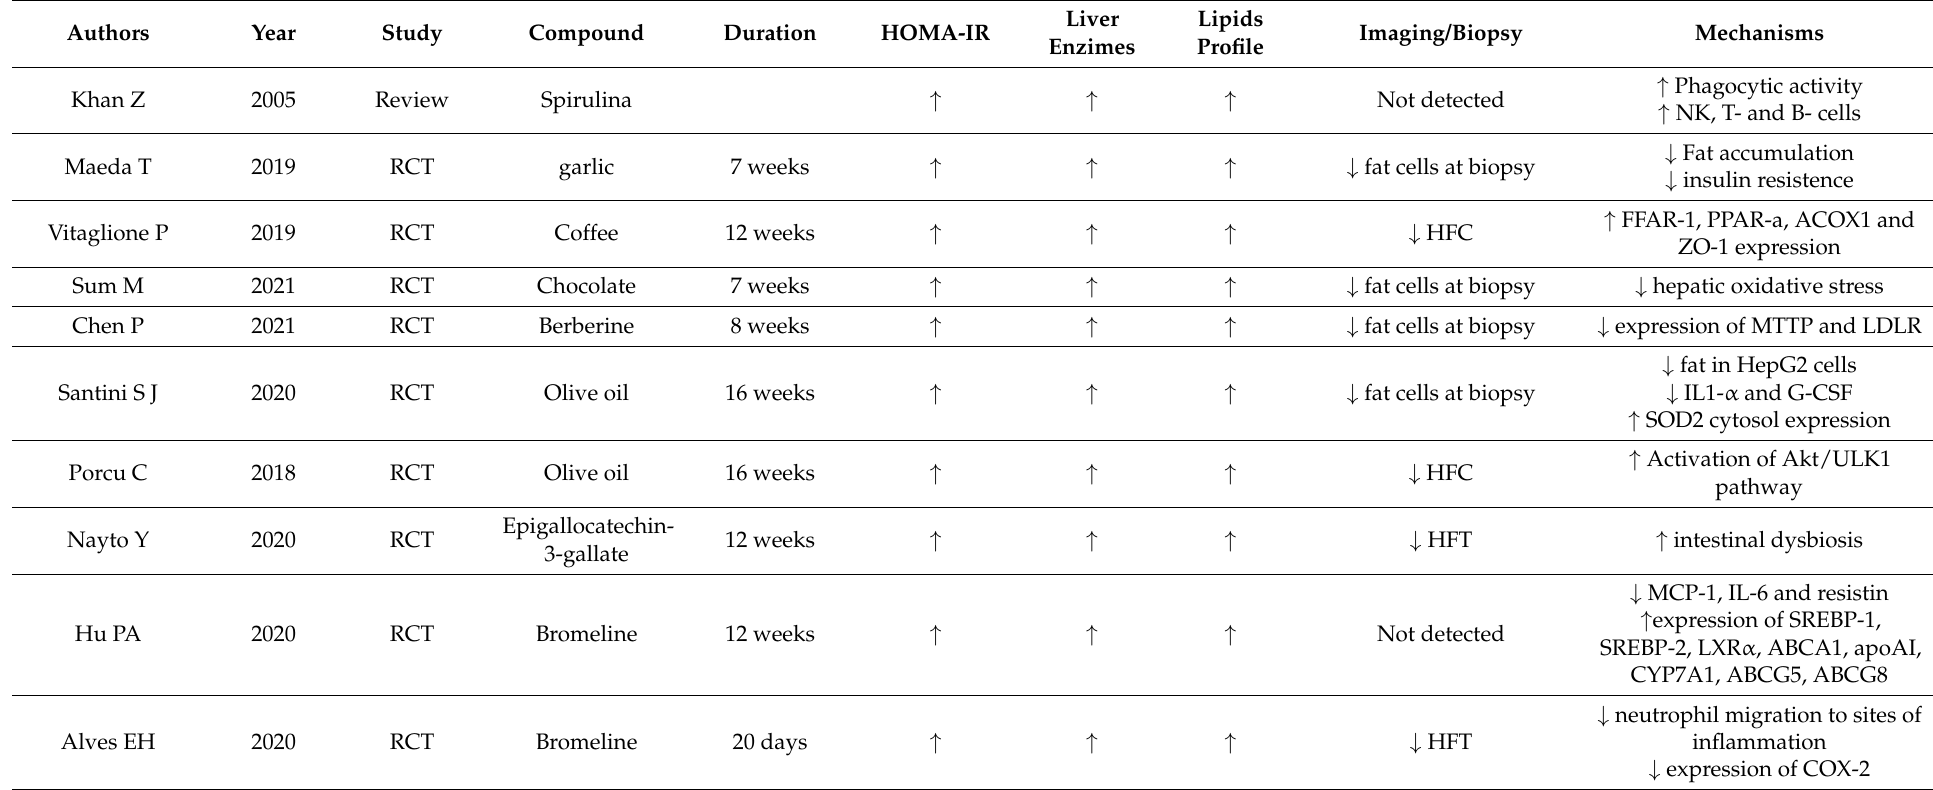
Table 2. Characteristics of preclinical studies taken into account to prove the efficacy of natural products on